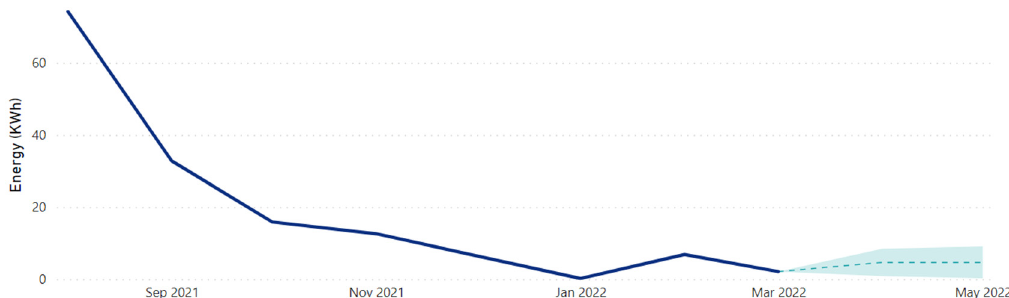
Figure 13. Energy consumption forecast for Operation 1.